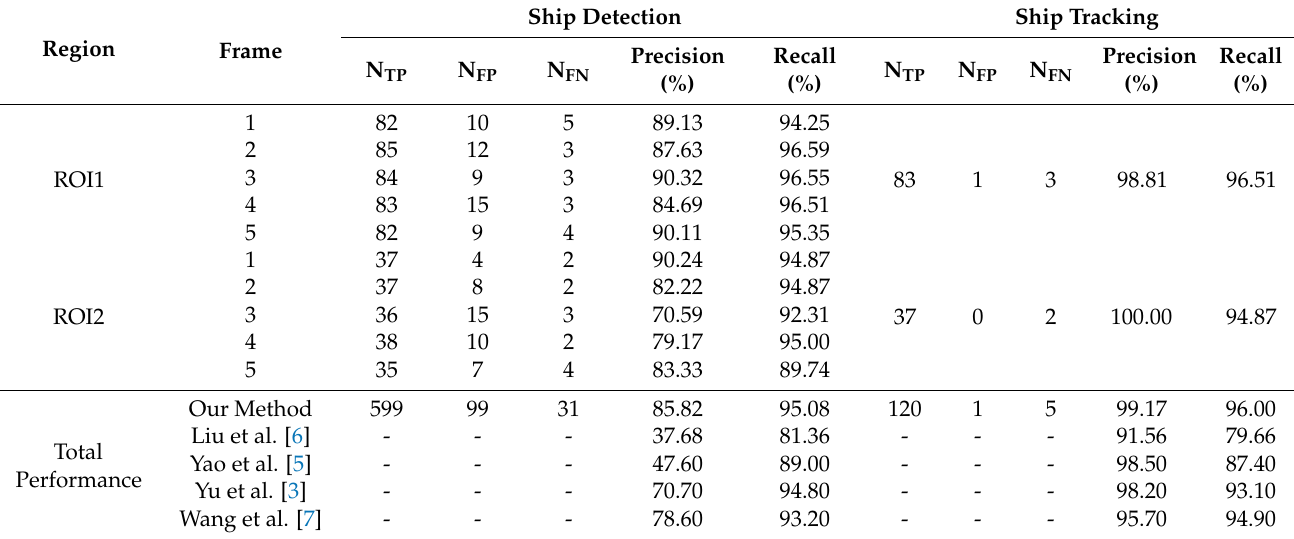
Table 1. Metrics comparison of ship detection and tracking.